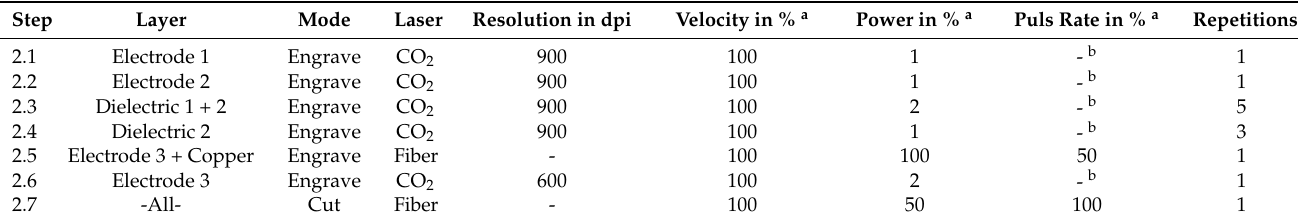
Table 4. Laser manufacturing parameters of the dielectric pressure